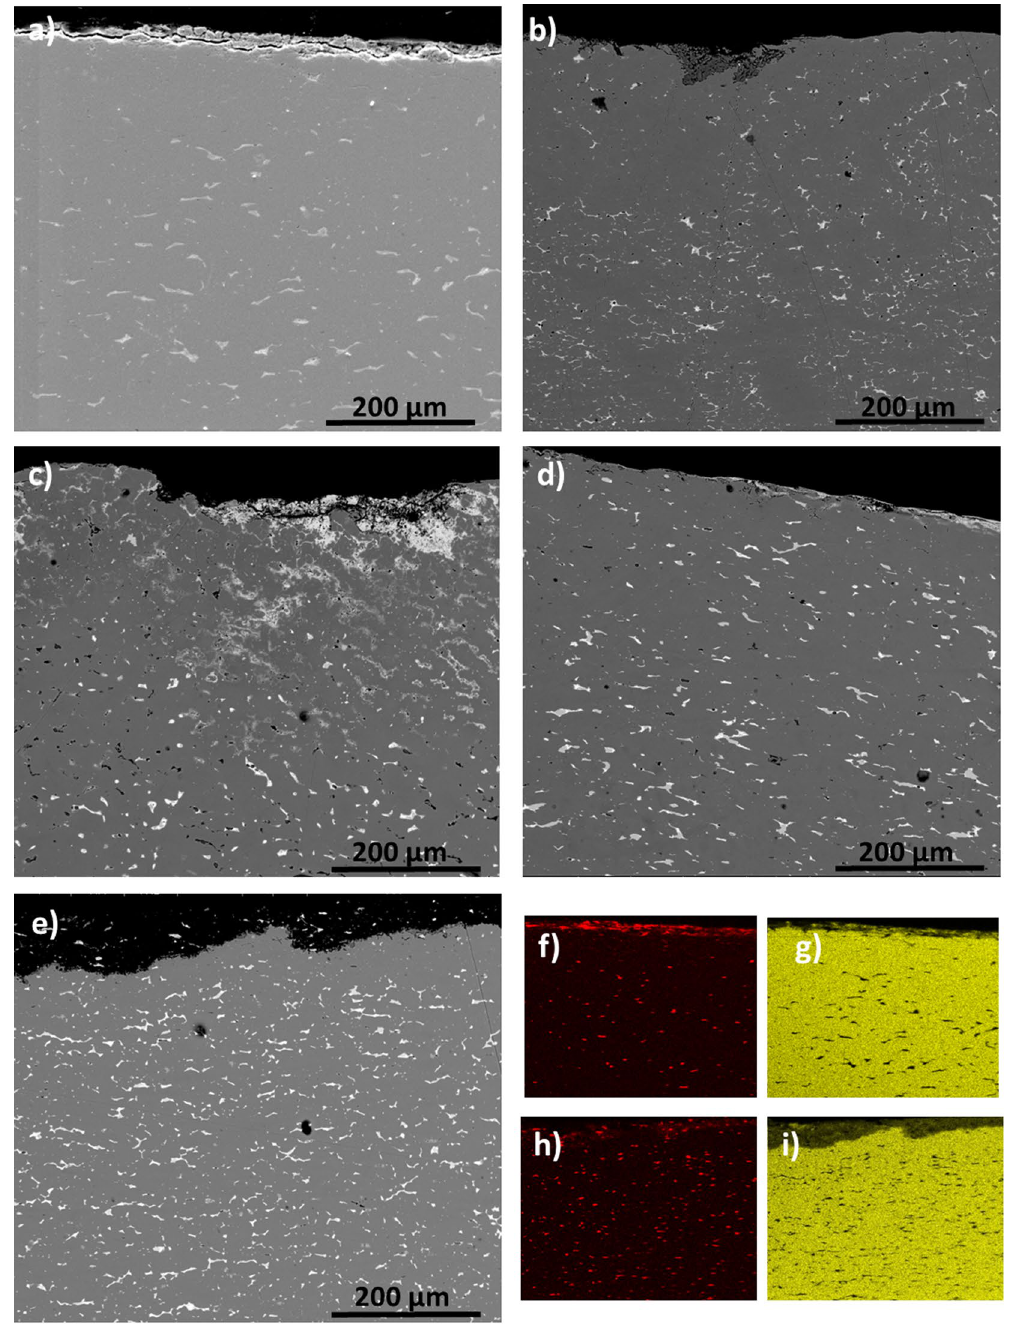
Figure 2. BSE images of Antoninianus coins ( a ) A ( b ) B ( c ) D ( d ) E ( e ) I and X-ray maps of ( f,h ) Ag and ( g,i ) Cu of coins A and